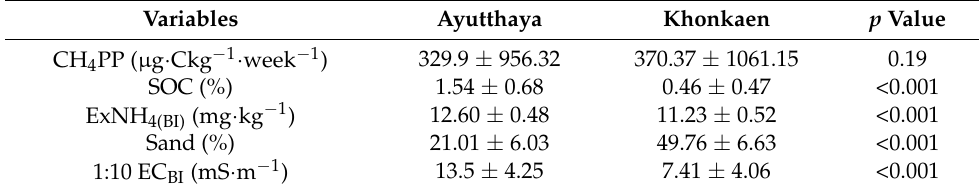
Table 4. Map datasets: Average and standard deviation of CH 4 production potential (CH 4 PP) and major soil properties and significant level for the difference between Ayutthaya and Khonkaen by